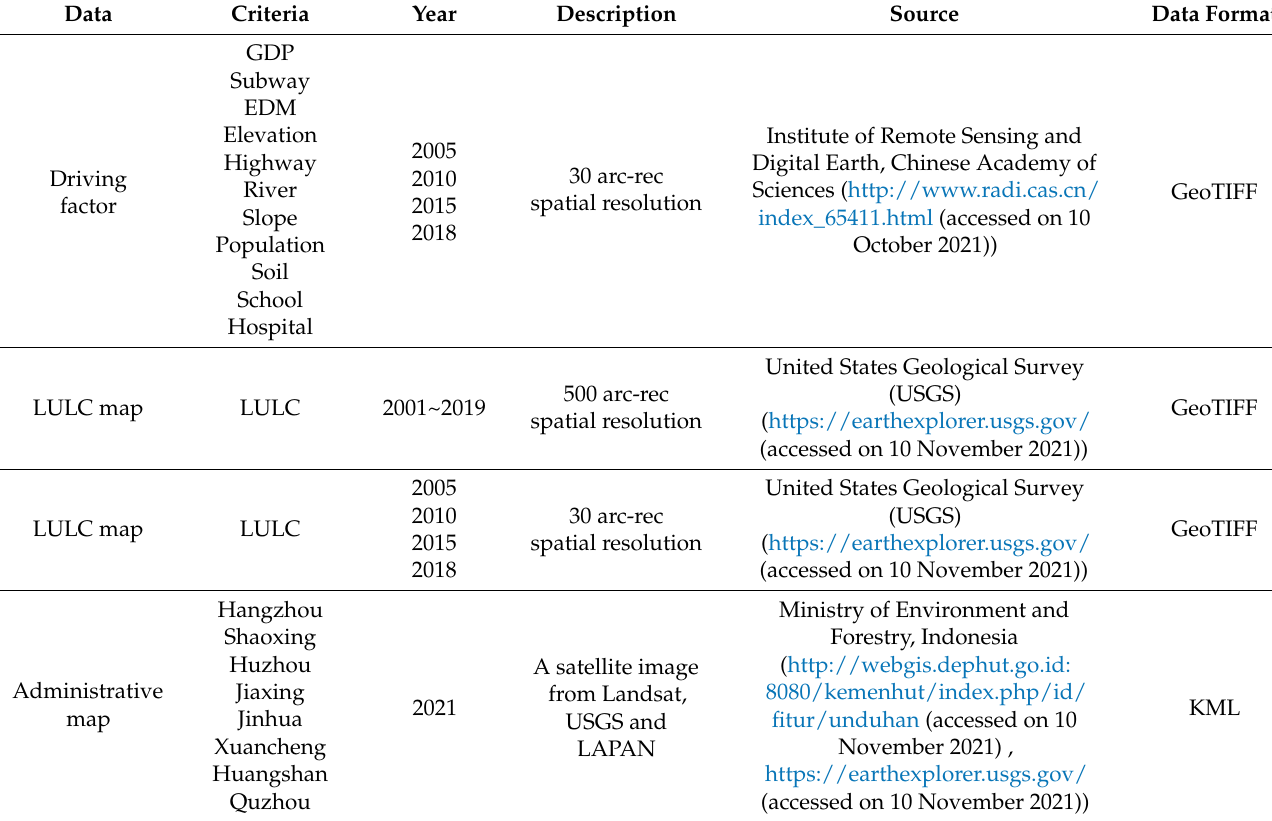
Table 1. Summary of data